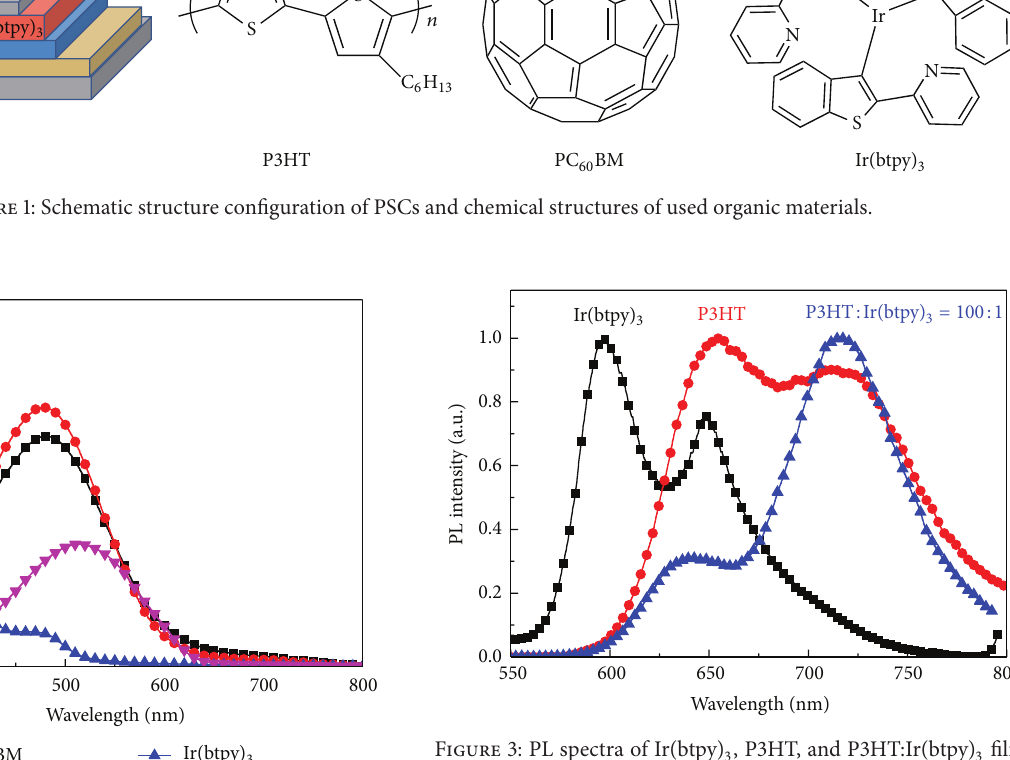
Figure 3: PL spectra of Ir(btpy) 3 , P3HT, and P3HT:Ir(btpy) 3 films under the excitation of 410nm